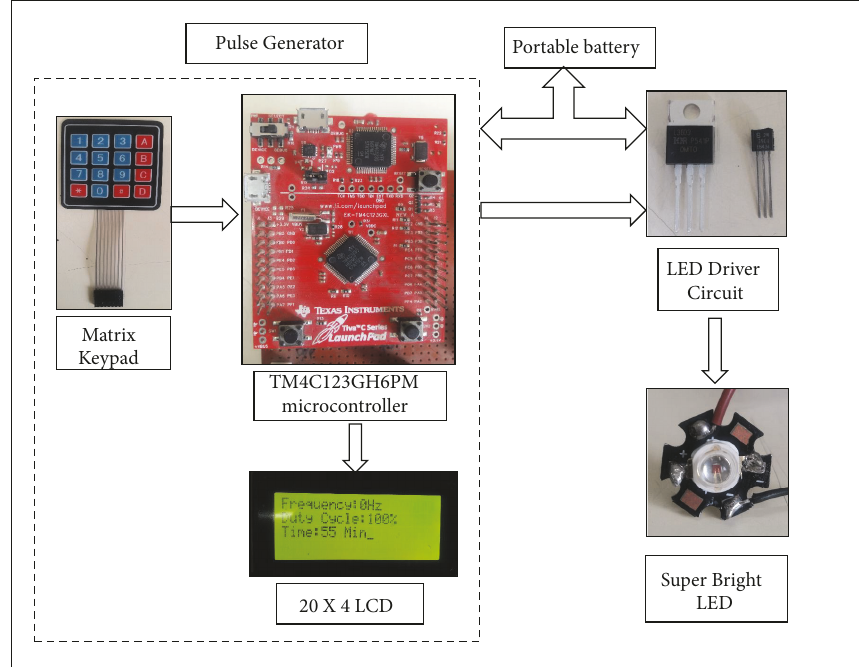
Figure 1: System overview of LED based phototherapy system comprising of the pulse generator, driver circuit, and LED